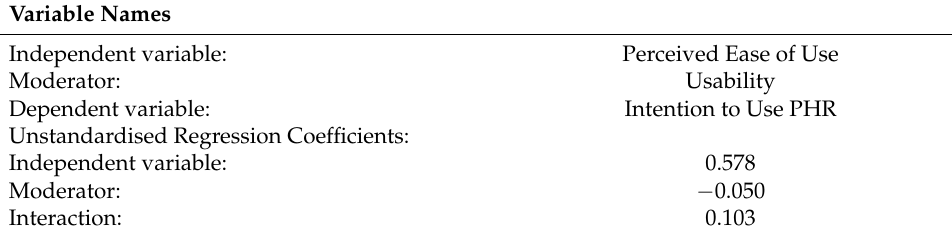
Figure 3. Usability Positively Moderated the Relationship between Perceived Ease of Use and Intention to Use PHR. Table 7. Two-way Interaction Effects for Unstandardised Variables (PEOU, Usability, and Intention to Use